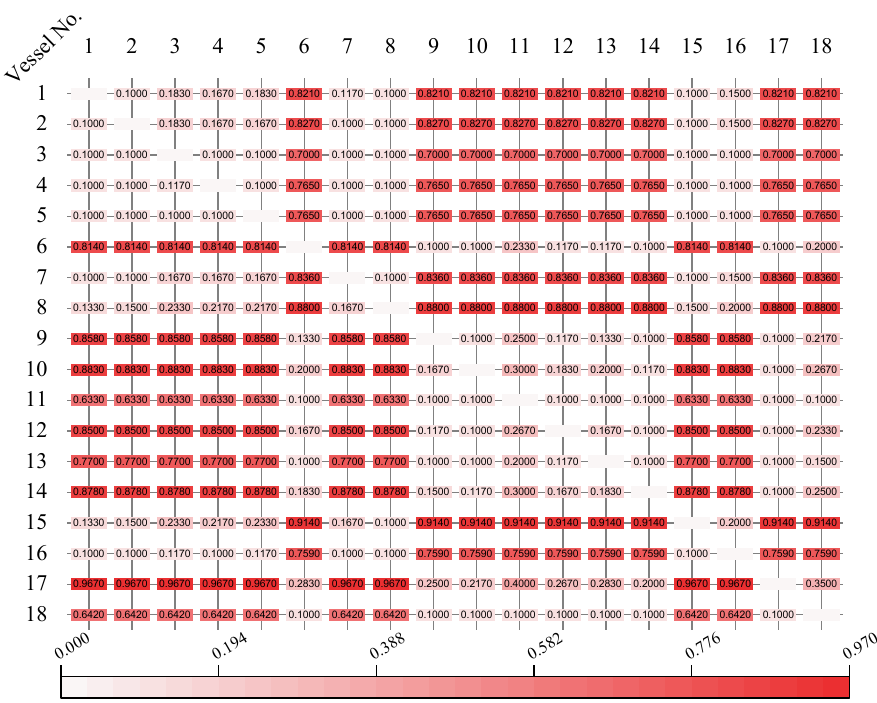
Figure 9. The minimum safe time interval of 18 vessels.